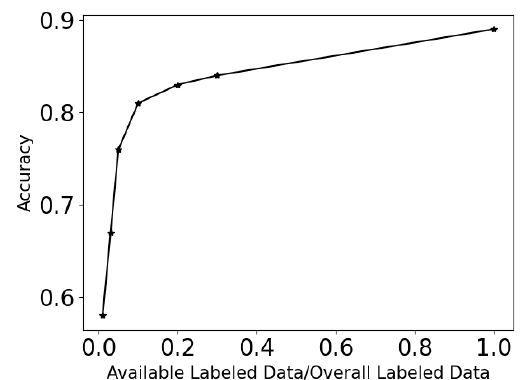
Figure 6. SVM classification accuracy and the number of labeled samples.